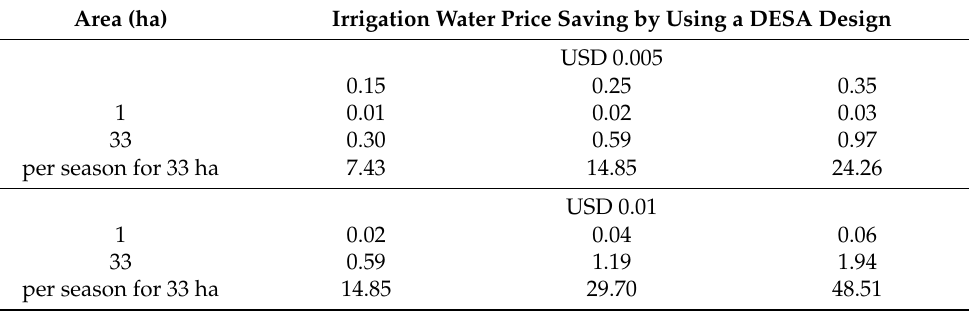
Table 5. Irrigation water price saving by the DSEA design during an irrigation event. Area (ha) Irrigation Water Price Saving by Using a DESA